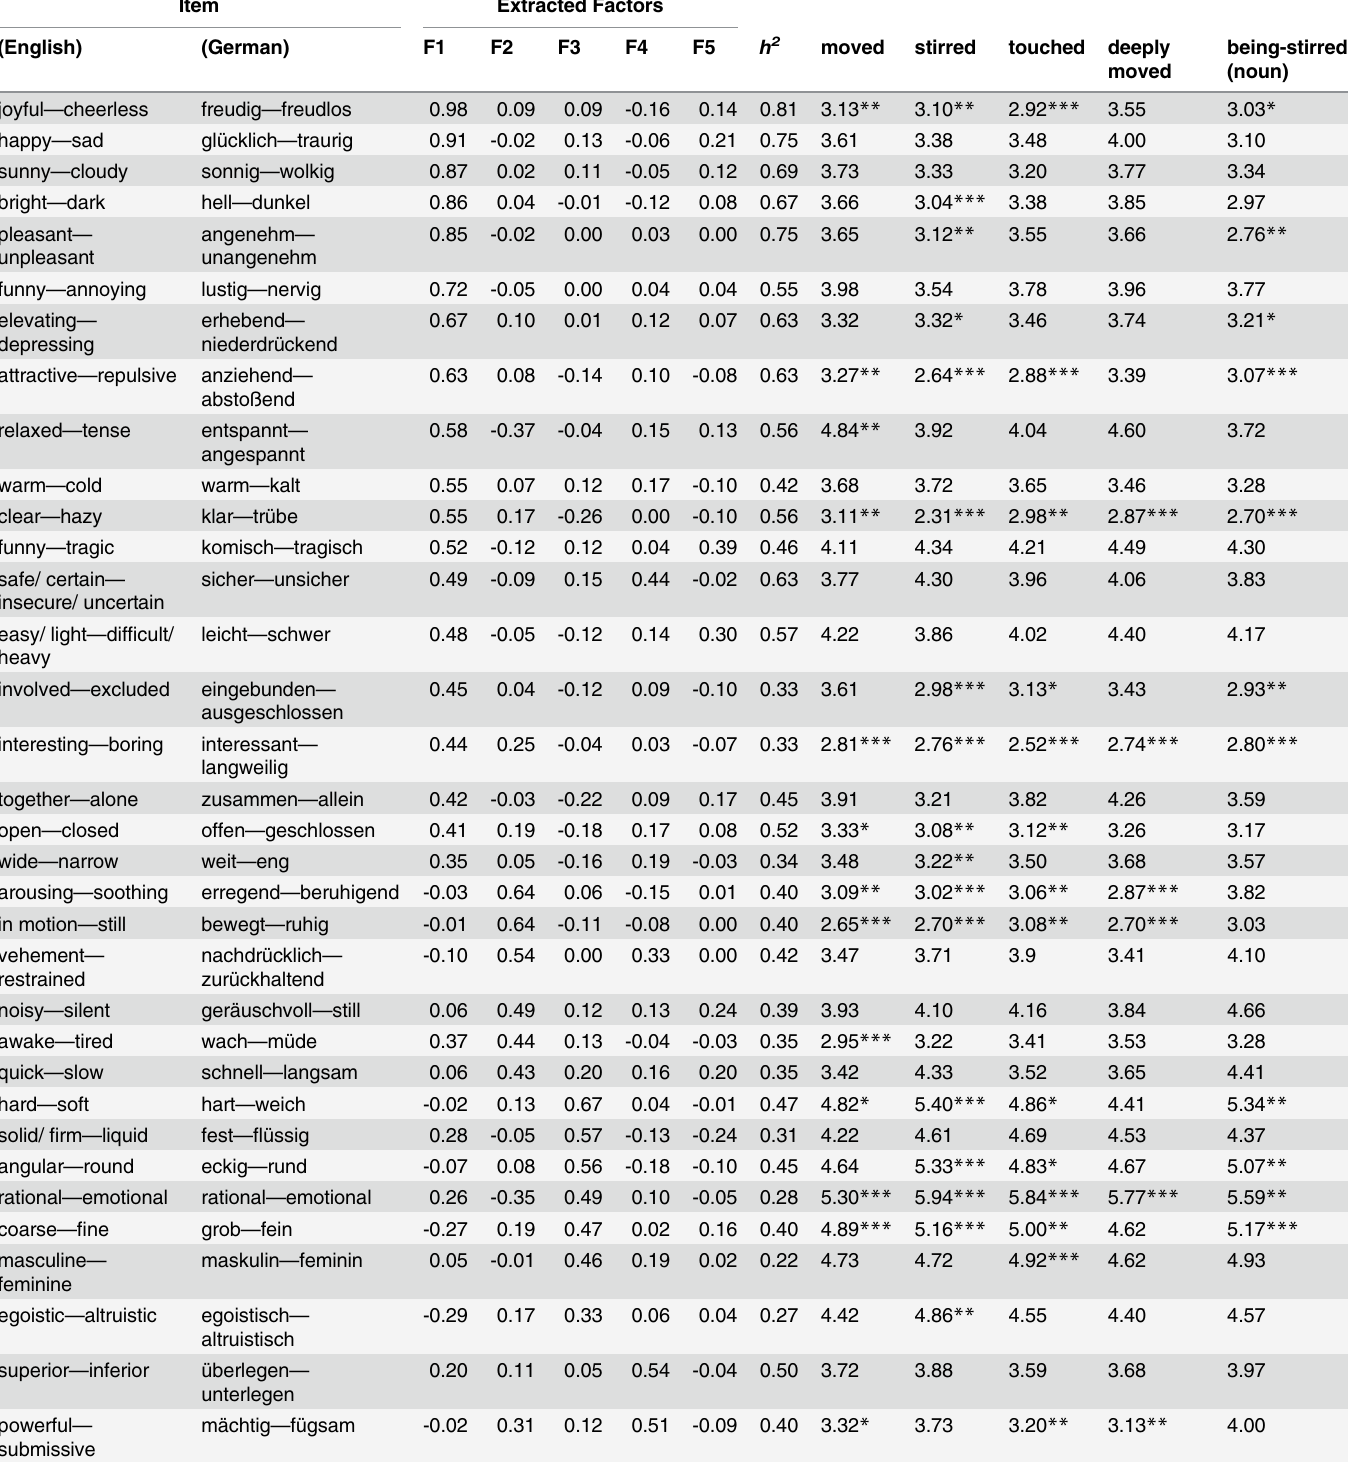
Table 4. Results of the exploratory factor analysis for Study 3. Item Extracted